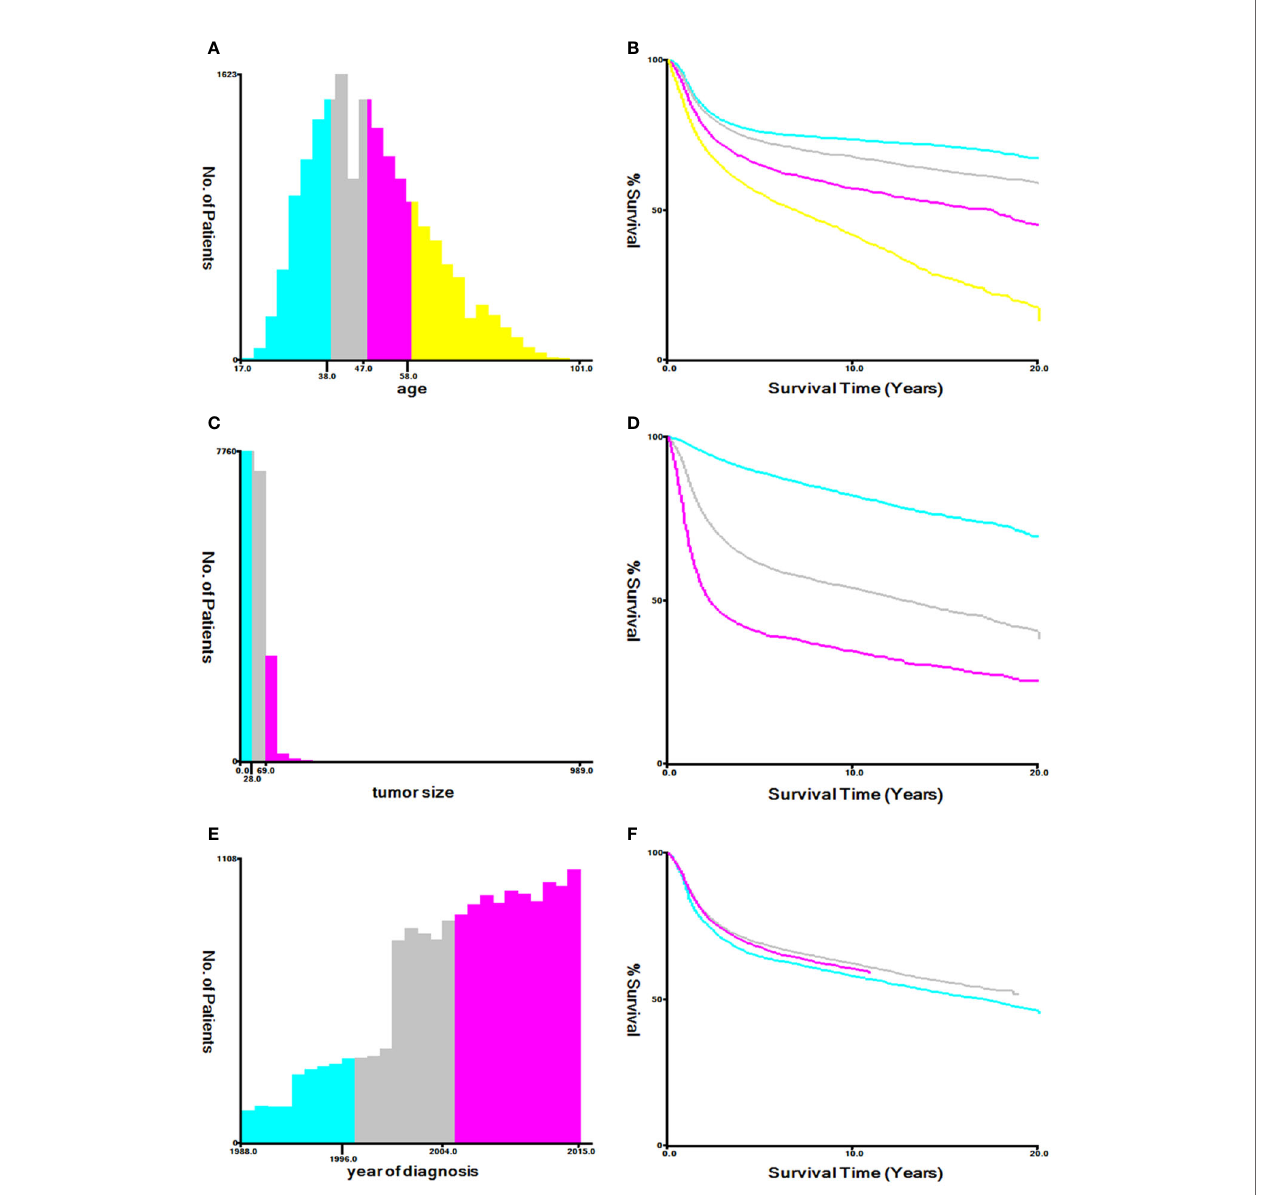
FIGURE 2 | Optimal cutoff values for patient ’ s age (A, B) , tumor size (C, D) , and year of diagnosis (E, F) through X-tile software analysis. The optimal age cut-off values determined by overall survival were 38, 47, and 58 years. The optimal tumor size cutoff values determined by overall survival were 28 mm and 69 mm. The optimal year of diagnosis cutoff values determined by overall survival were 1996 and